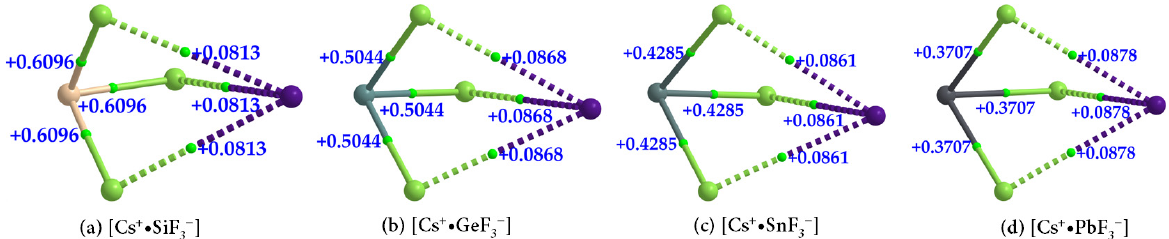
Figure 13. ( a – d ) QTAIM-based molecular graphs of cesium tetrel fluoride perovskite ion pairs, [Cs + •TtF 3 − ] (Tt = Si, Ge, Sn, and Pb), obtained with [ ω B97XD/def2-TZVPPD]. Values represent the Laplacian of the charge density ( ∇ 2 ρ b /au) at the Tt–F and Cs···F bond critical points. Atoms, bond paths, and bond critical points are shown as large spheres, solid/dotted lines in atom color, and tiny spheres in green, respectively. Table 4. Selected QTAIM-based topological charge density properties at Tt–F and Cs···F bcps of